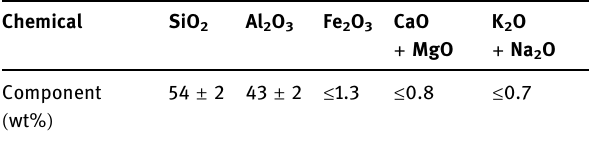
Table 2: Chemical composition of MK Chemical